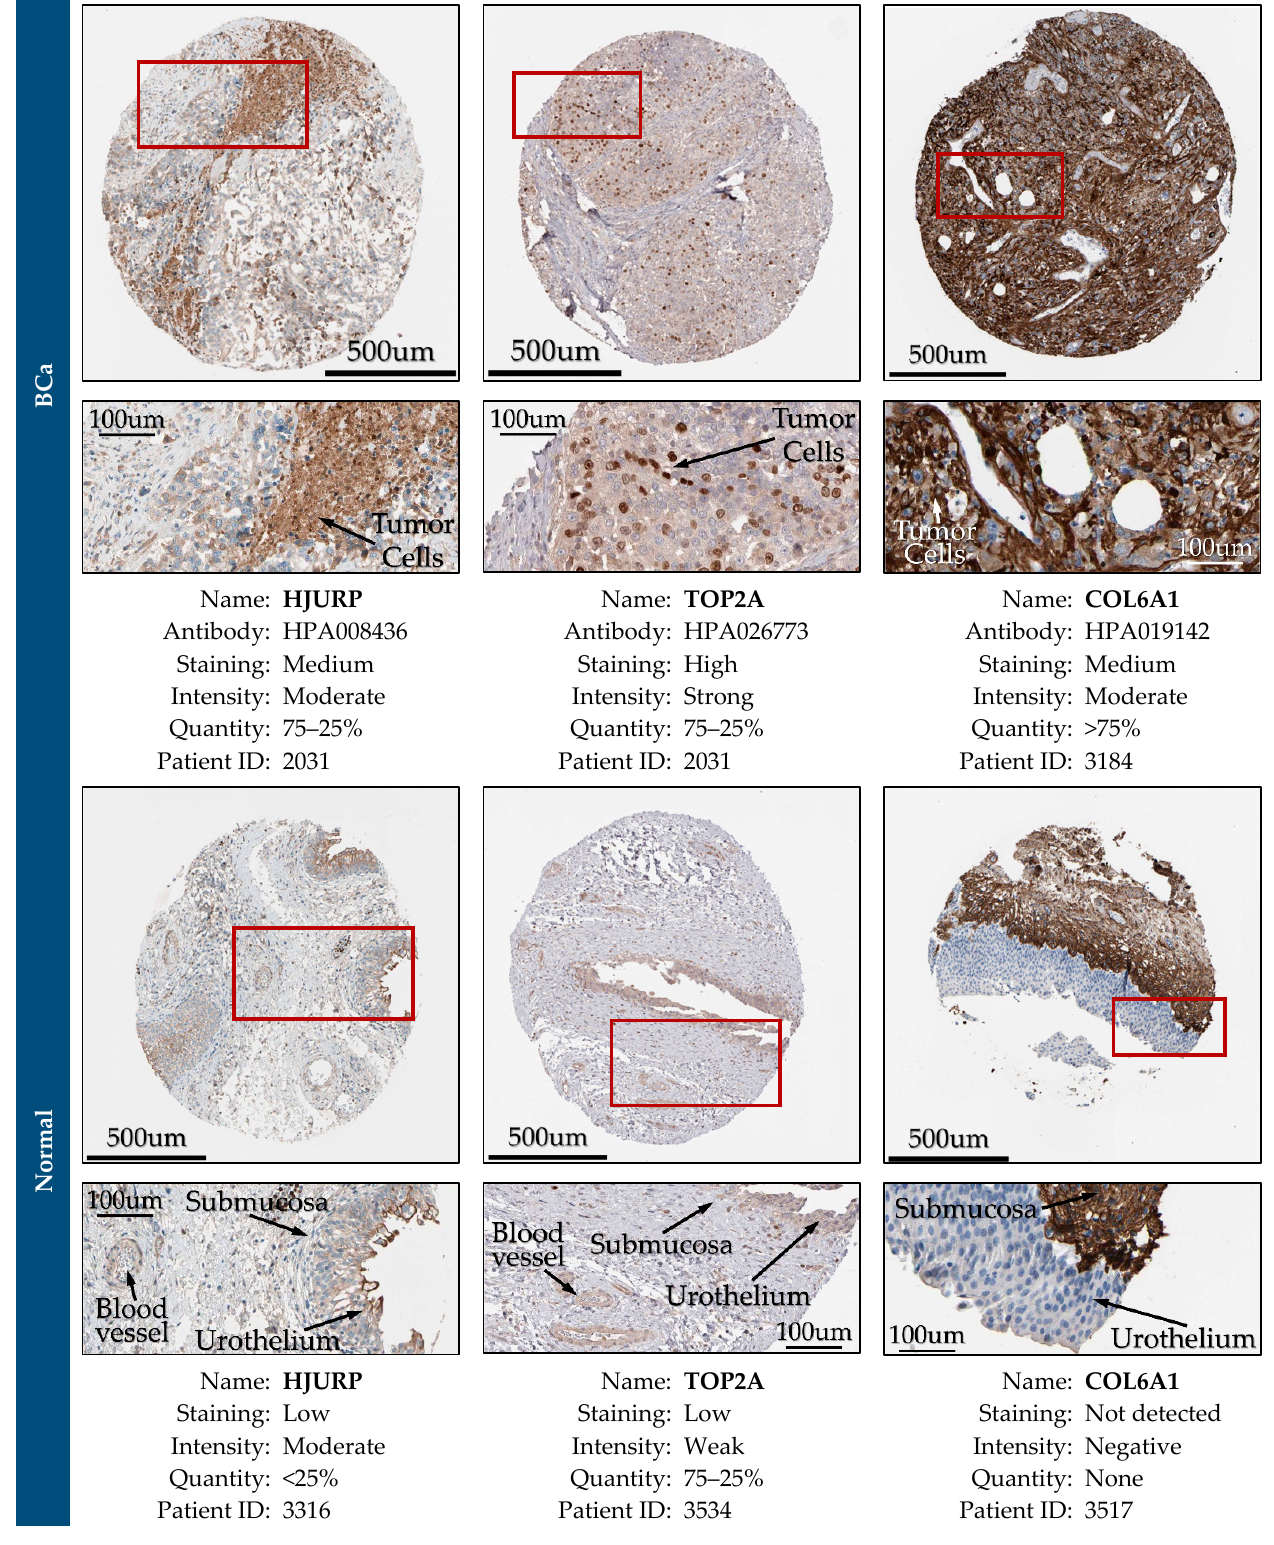
Figure 28. Immunohistochemical (IHC) validation of the nine key biomarker genes in cancer and normal human bladder tissue specimens, obtained from the Human Protein Atlas (available online: www.proteinatlas.org (accessed on 04 July 2022)). Staining demonstrated that protein expression of the nine key biomarker genes was higher in BCa tissues compared to normal bladder tissue samples.